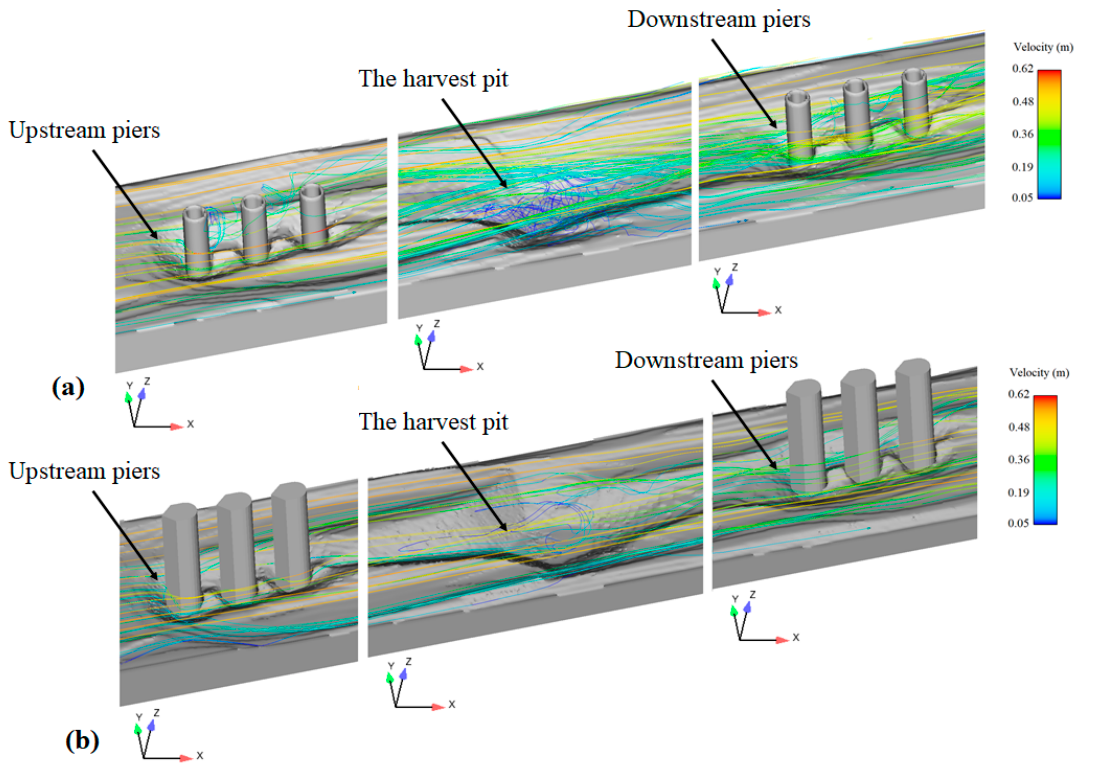
Figure 9. Flow patterns for the pier group and the material harvest pit: ( a ) Circular model; ( b ) hydrodynamic model.